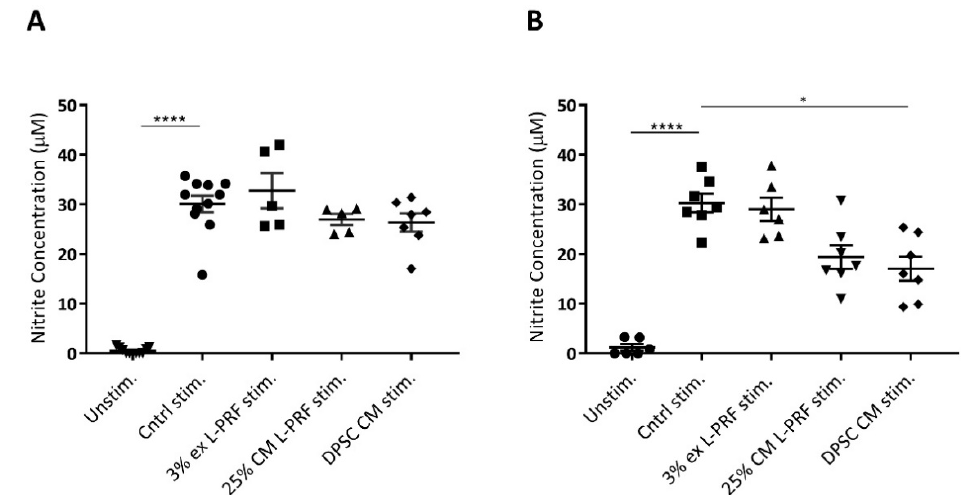
Figure 5. The e ff ect of L-PRF ex, L-PRF CM and DPSC CM on TNF- α and IL-1 β -stimulated iMAC nitrite release. Nitrite production in iMACs cultured in monolayer ( A ) and micropellet ( B ) was measured via the Griess assay. ( A ) In monolayer culture, nitrite production was significantly increased upon cytokine stimulation but not significantly altered by exposure to L-PRF ex, L-PRF CM and DPSC CM after 24 h. ( B ) In 3D micropellets, DPSC CM significantly reduced nitrite release of iMACs after 72 h. Data correspond to n = 5 for L-PRF ex and L-PRF CM, n = 7 for DPSC CM (A), n = 6 for L-PRF ex, n = 7 for L-PRF CM and DPSC CM (B). Data are represented as mean ± S.E.M. * p ≤ 0.05. **** p ≤